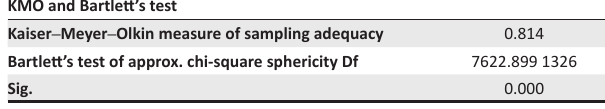
TABLE 2: Kaiser-Meyer-Olkin and Bartlett’s test of